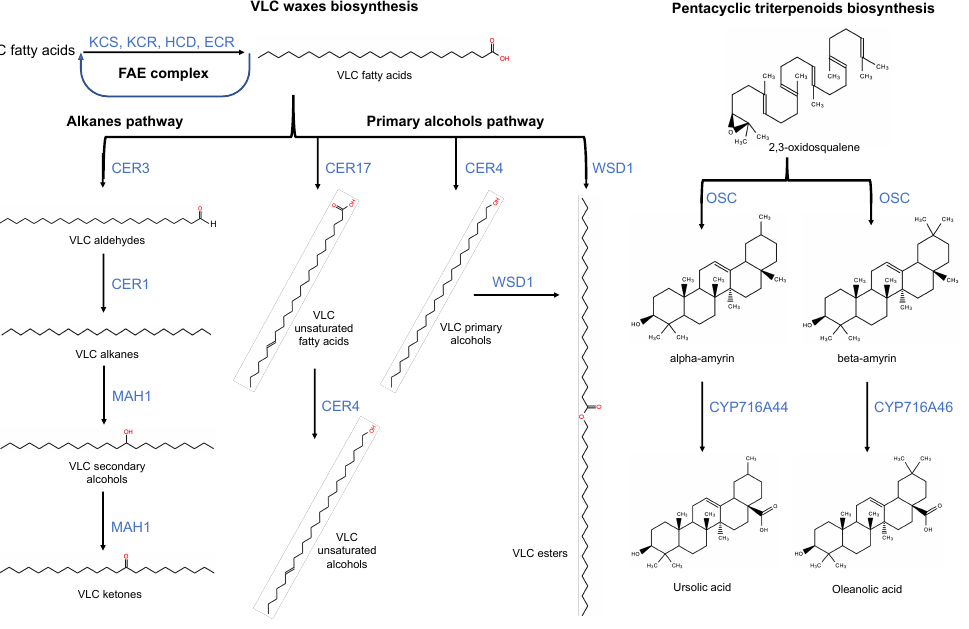
Figure 2. The biosynthesis pathway and chemical structure of common cuticular wax compounds found in the cuticle of fleshy fruits. Only the gene subfamily’s main name is included for reactions involving multiple paralogs. Twenty-four chain length carbon atoms are used to exemplify the main very long chain (VLC) wax compounds synthesized by the primary alcohols pathway. Twenty-three chain length carbon atoms are used to exemplify the main VLC wax compounds synthesized